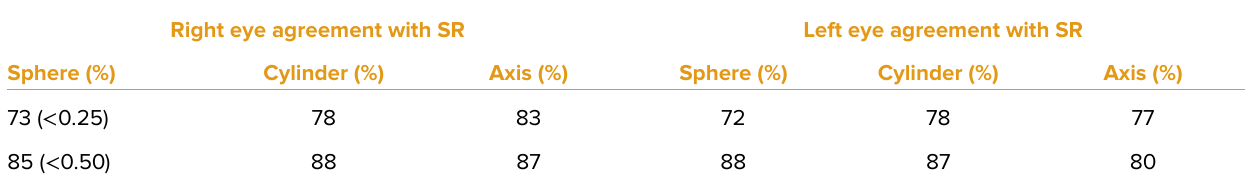
Table 2. Agreement of the AHAR with SR power vector errors in both eyes. Categories Right eye agreement with SR Left eye agreement with SR SPE M (%) J0 (%) J45 (%) SPE M (%) J45 (%) < 0.25 < 0.50 SR, subjective refraction; SPE, spherical equivalent Table 3. Agreement of the AHAR with SR errors in both eyes (compound representation). Right eye agreement with SR Left eye agreement with SR Sphere (%) Cylinder